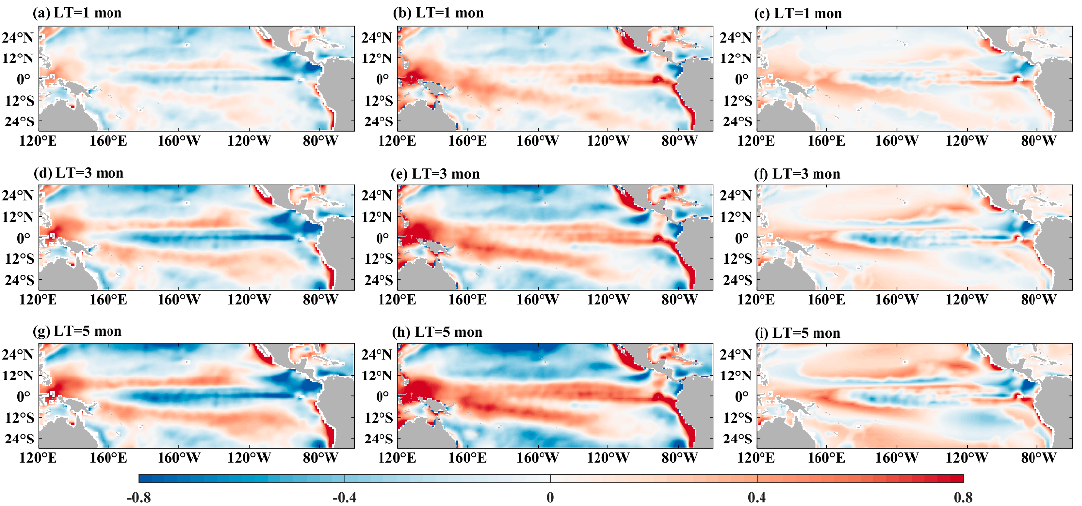
Figure 6. Spatial patterns of SSTA biases (units: °C) between the predictions and observation: FIO − ESM − CPS results ( a , d , g ), modified FIO − ESM − CPS results ( b , e , h ). The difference of absolute average error between modified and original FIO − ESM − CPS ( c , f , i ). ( a – c ) 1-month lead time, ( d – f ) 3-month lead time, and ( g – i ) 5-month lead time.